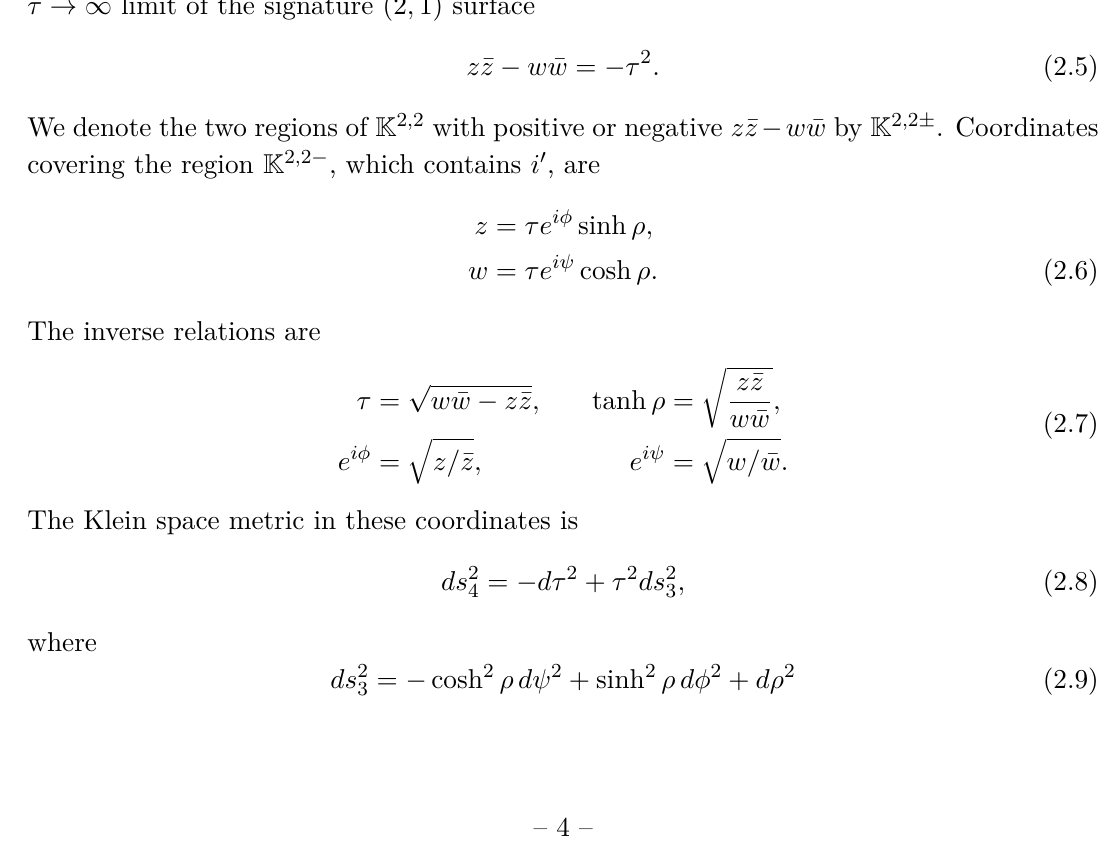
< U < π , V = π . 2 2 2 , π ) and has the conformal geometry of signature (1 , 2) 2 2 , π ) and has the conformal geometry of signature 2 2